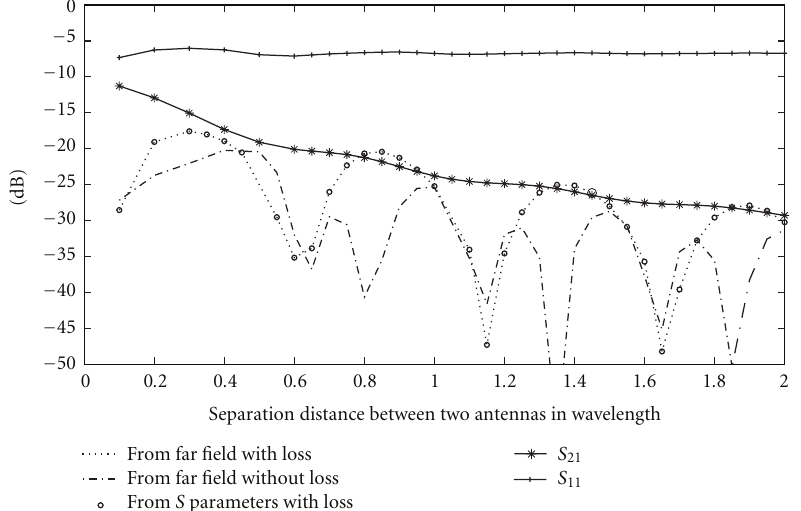
Figure 4: The computed spatial envelope correlations and scattering parameters between dipoles 1 and 3 versus their separation distance, in a MIMO system of three elements, arranged in a uniform linear